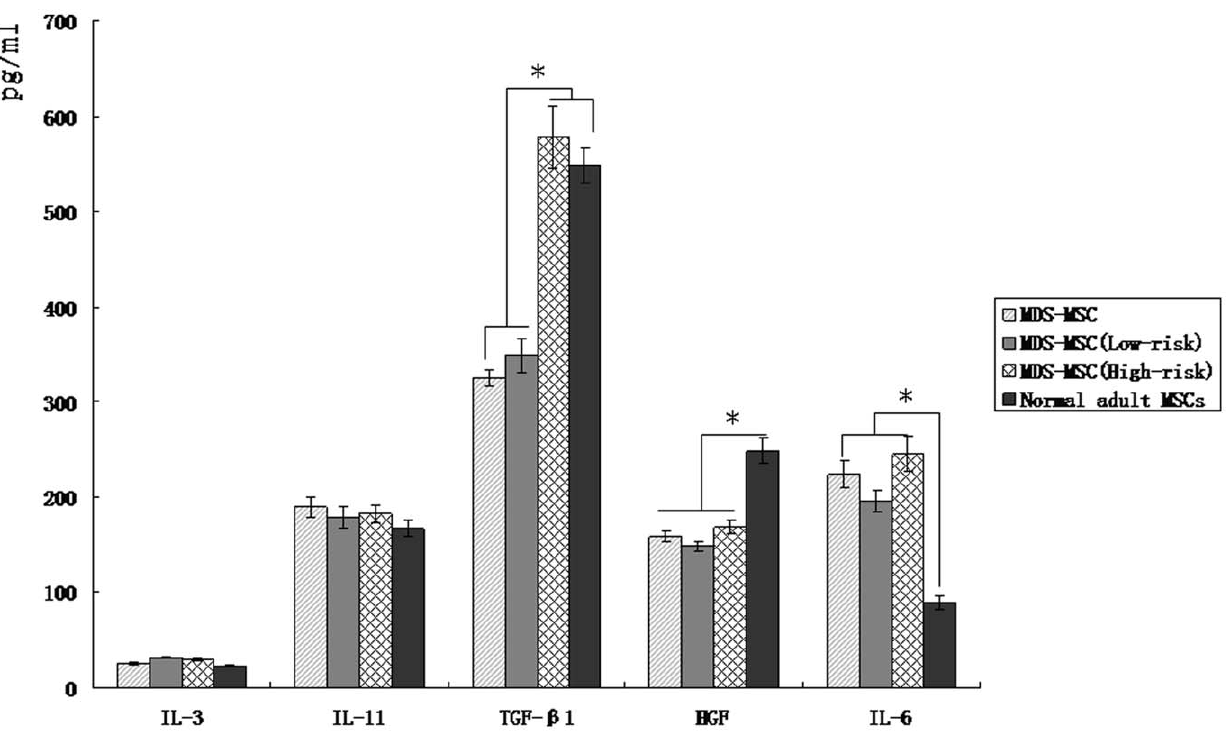
Figure 1. Cytokine secreted by MDS-MSC. The cytokine profiles of normal-MSC, MDS-MSC, high-risk MDS-MSC and low-risk MDS-MSC were assayed by ELISA. Data are expressed as mean 6 SD of triplicates of 4 separate experiments. *P # 0.05.